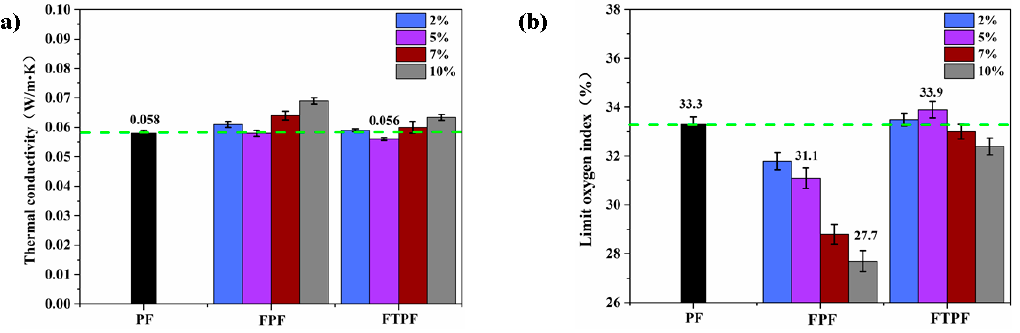
Figure 7. ( a ) Thermal conductivity and ( b ) limiting oxygen index of the PF, FPFs, and FTPFs.